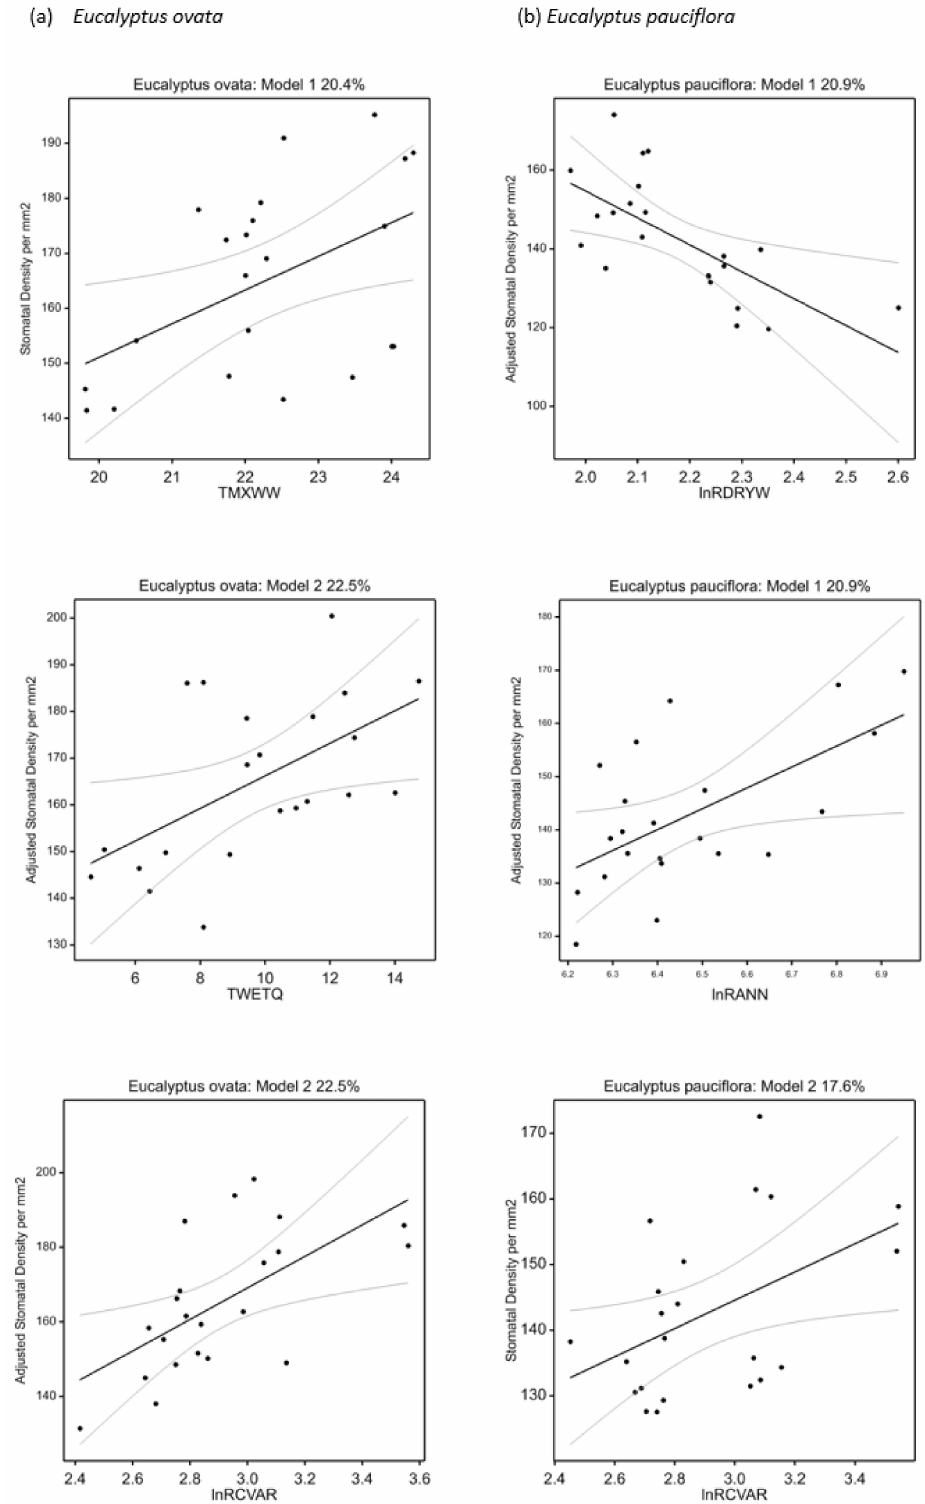
Figure 3. Partial dependency plots for selected regression models for stomatal density: ( a ) E. ovata , and ( b ) E. pauciflora (see Table 6). The percentage of the total variance explained (R 2 ) in the response variable is provided for each full model, and the relationships of stomatal density with each of the climate predictor variables included in each model are shown (adjusted for other predictors modelled where appropriate). The overall models and their regression parameters for the climate predictors were statistically significant at p < 0.05. The 95% confidence intervals are also